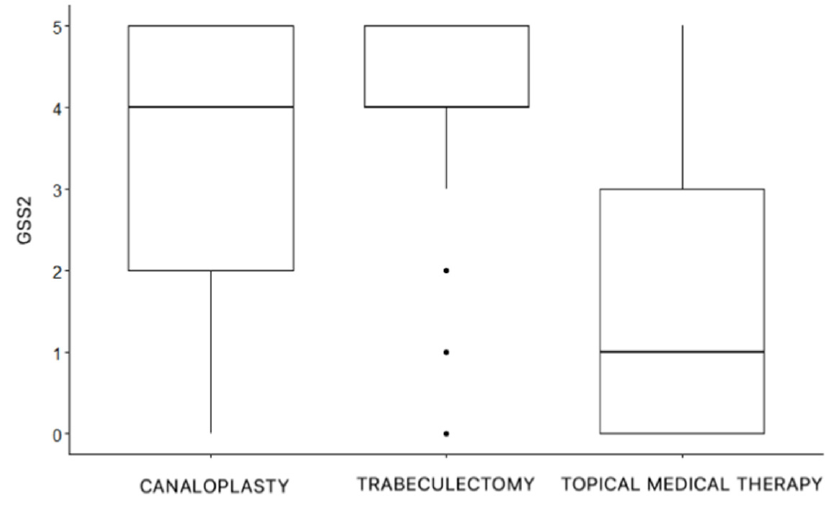
Figure 1. Visual field defect stages according to GSS2 in the three treatments groups.